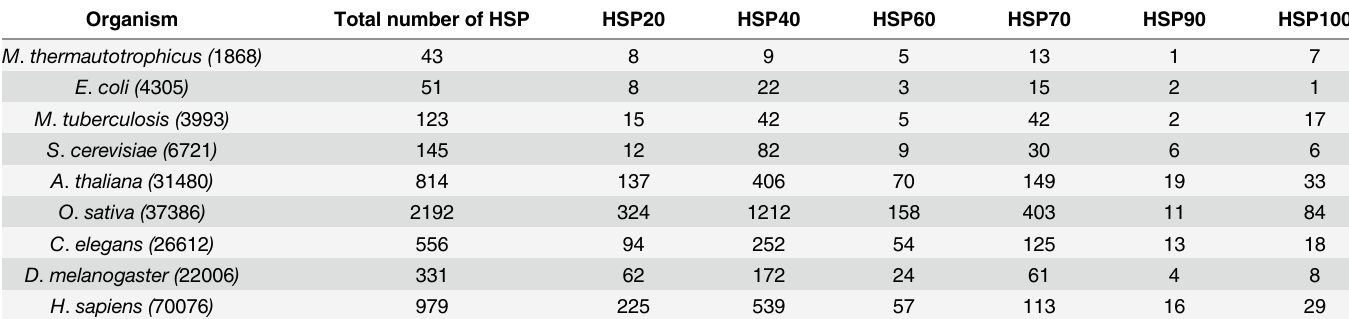
Table 7. Genome wide annotation of heat shock proteins in different